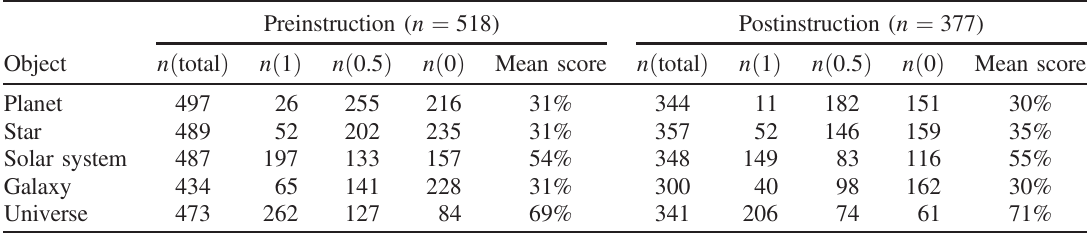
TABLE I. Middle school students ’ scores on the explaining task (Q5b), for both the pre- and postinstruction samples. For each object, the total number of students answering the question, the number of students scoring 0, 0.5, or 1 out of 1, and the mean score for the object (arithmetic mean over all students ’ scores for that object) is shown.